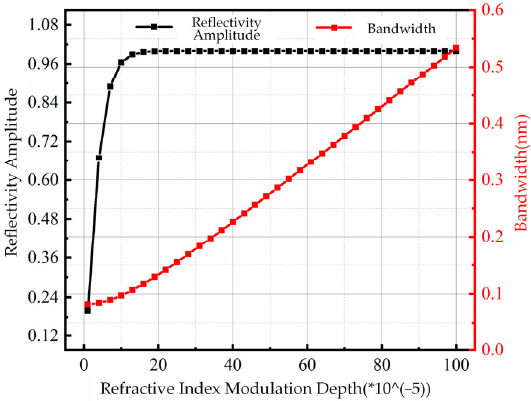
Figure 5. Curve of spectral reflectance amplitudes and bandwidths of FBG with different refractive index modulation depths.